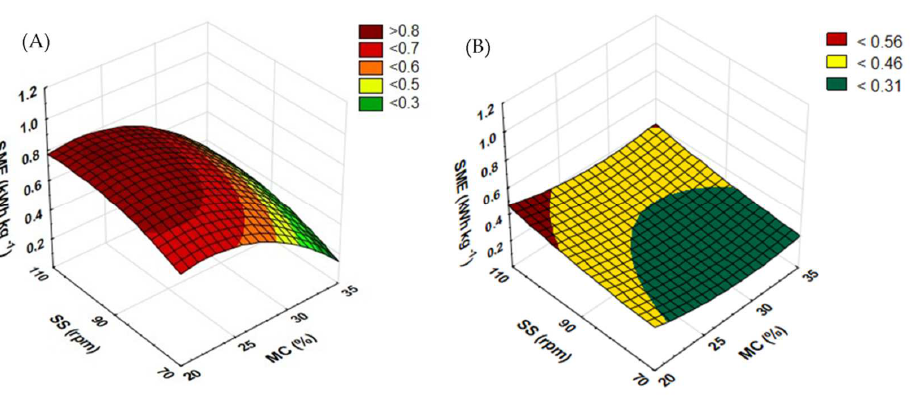
Figure 7. Specific mechanical energy of the extrusion-cooking of rapeseed straw ( A ) and buckwheat straw ( B ) after modification of the plasticizing system: MC—moisture content; SS—screw speed; SME—specific mechanical energy.